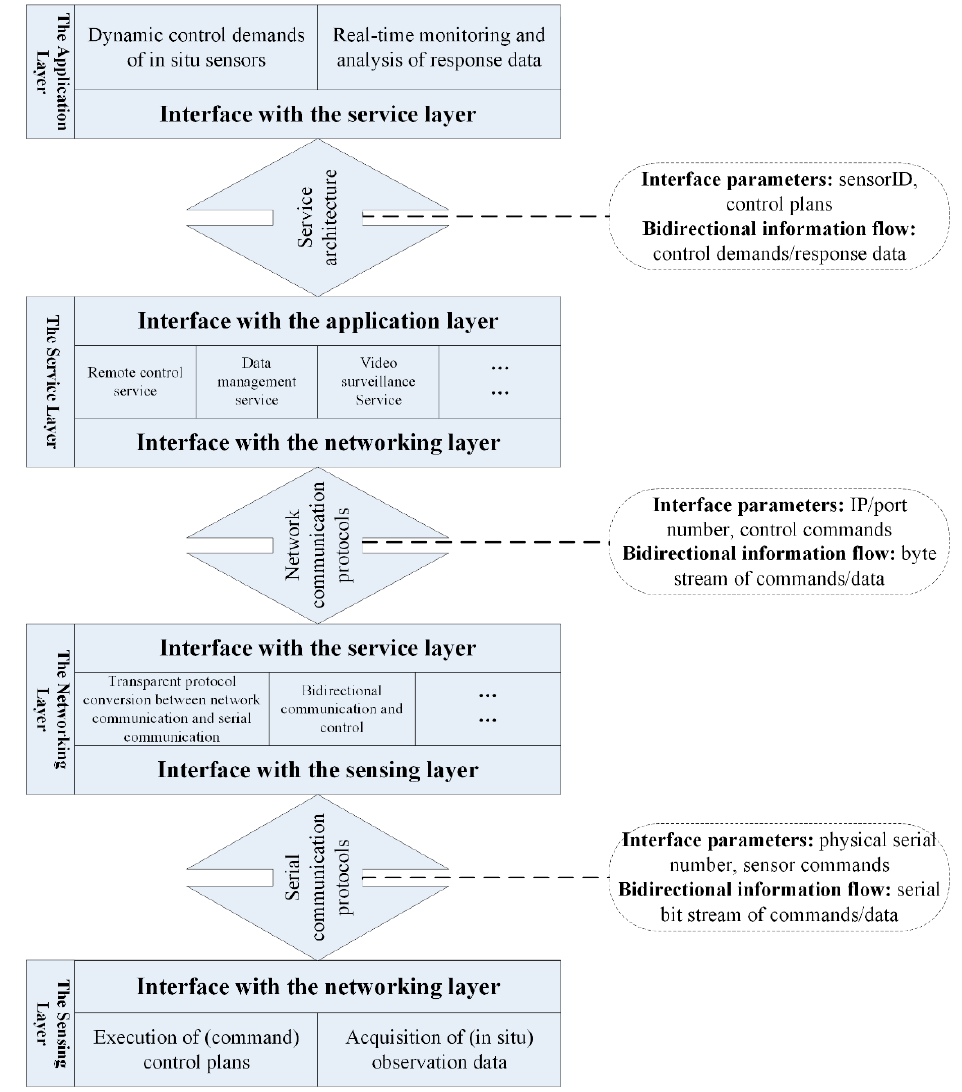
Figure 3. Interfaces between Adjacent Layers.